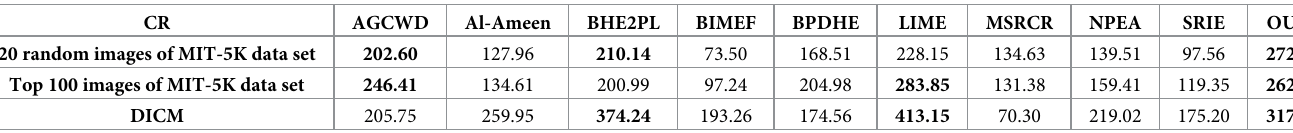
Table 12. Average image contrast ratio values of three groups of